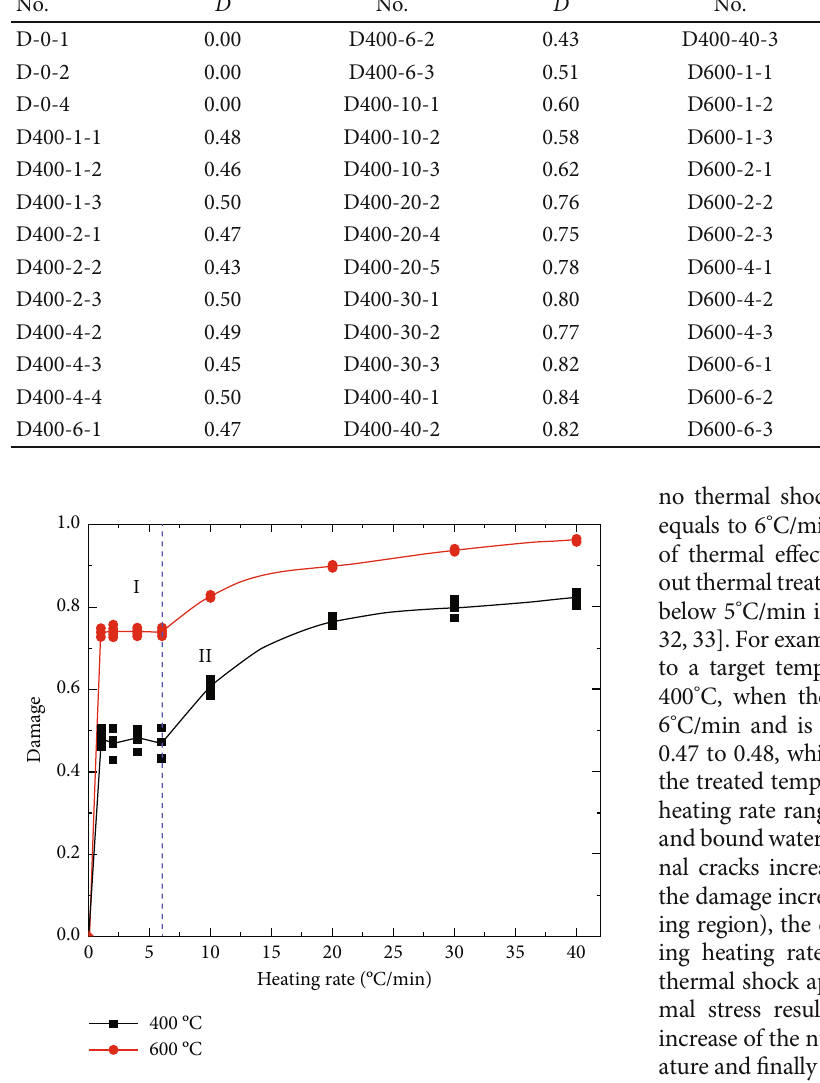
Figure 7: The damage of thermal shock treated granite